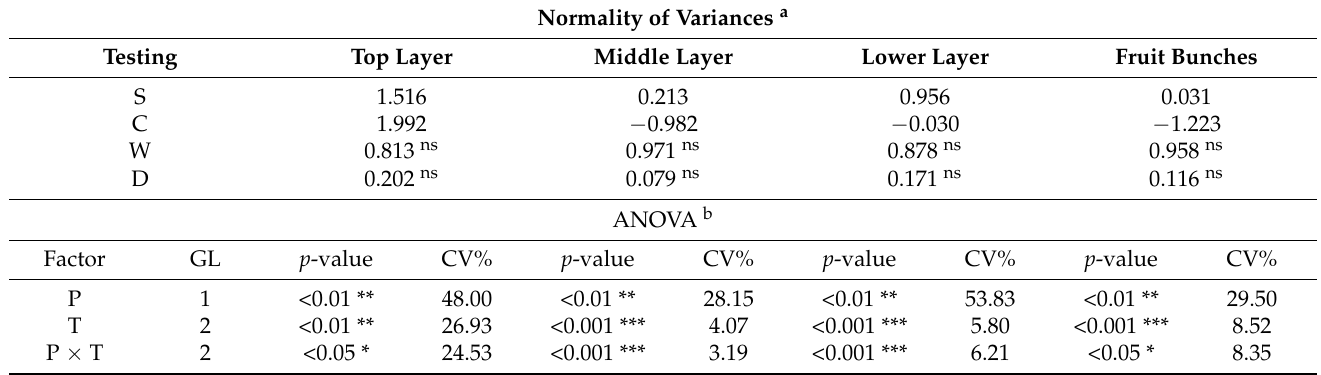
Table 4. Normality and analysis of variance (ANOVA) for droplet deposition in different layers of plants and fruit bunches of